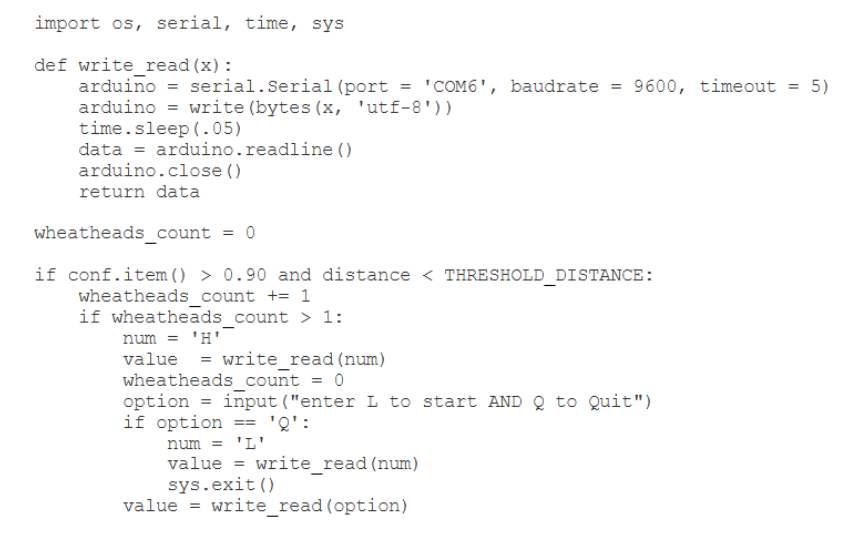
Figure 8. Code snippet to perform collision